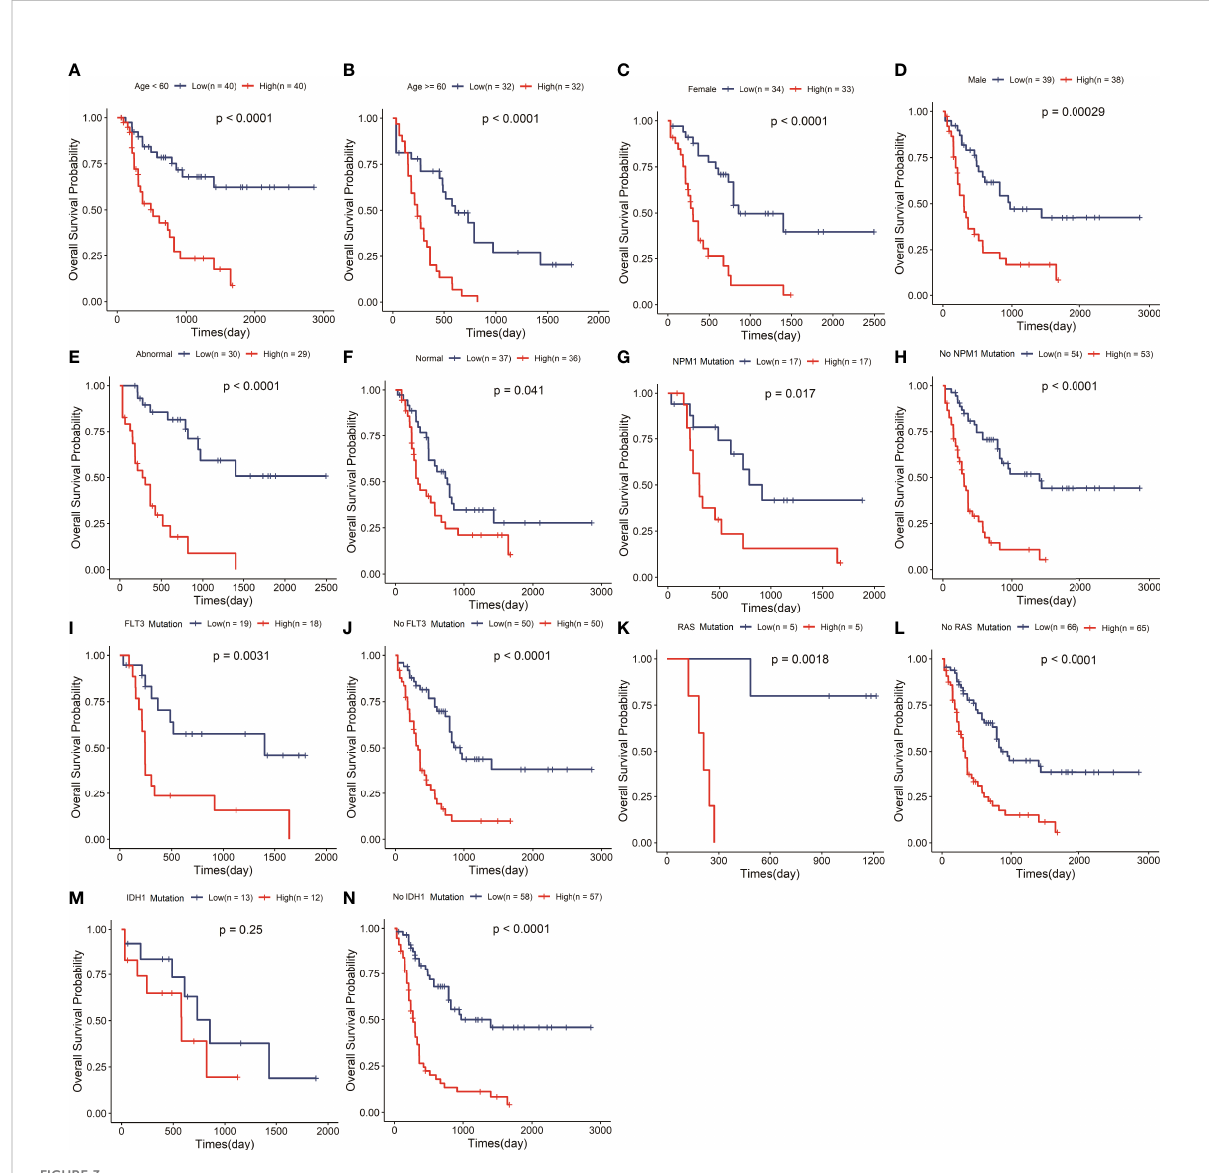
FIGURE 3 The signature retained great prognostic value in different subgroups of AML patients. Survival analysis in the two risk groups under diverse situations classi fi ed by several clinical features including age (A, B) , gender (C, D) , status of chromosome (E, F) , status of NPM1 (G, H) , status of FLT3 (I, J) , status of RAS (K, L) and status of IDH1 (M, N)